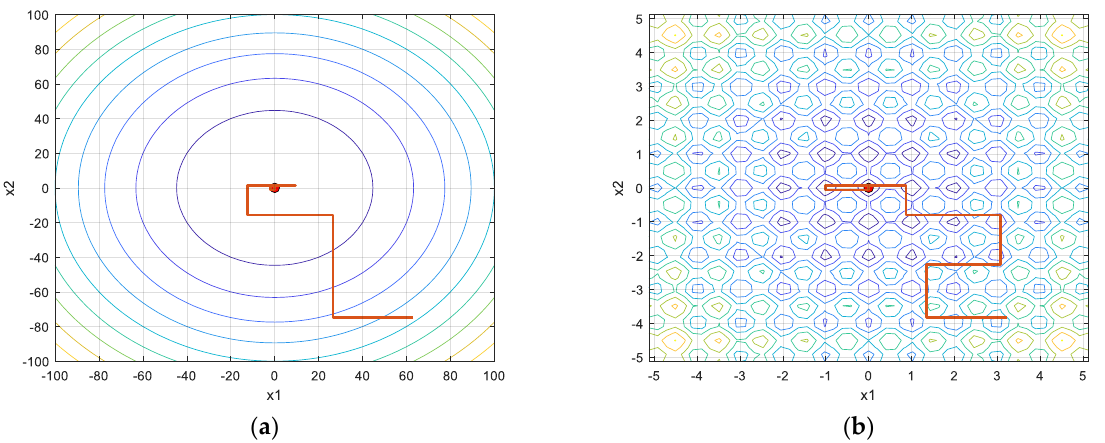
Figure 1. Flowchart of the PROS algorithm.